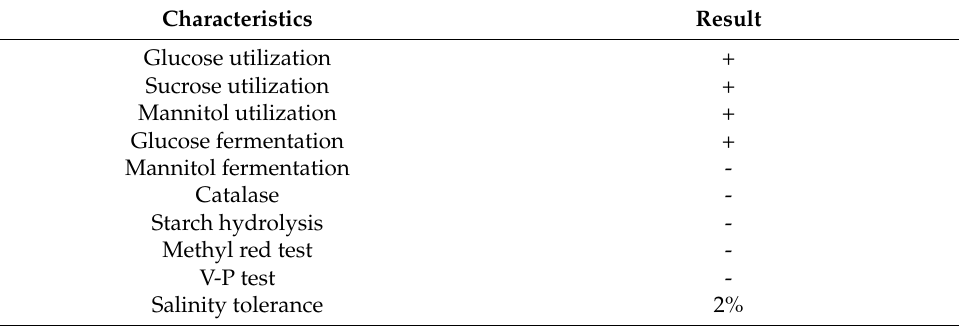
Table 4. Physiological and biochemical characteristics of strain S1.